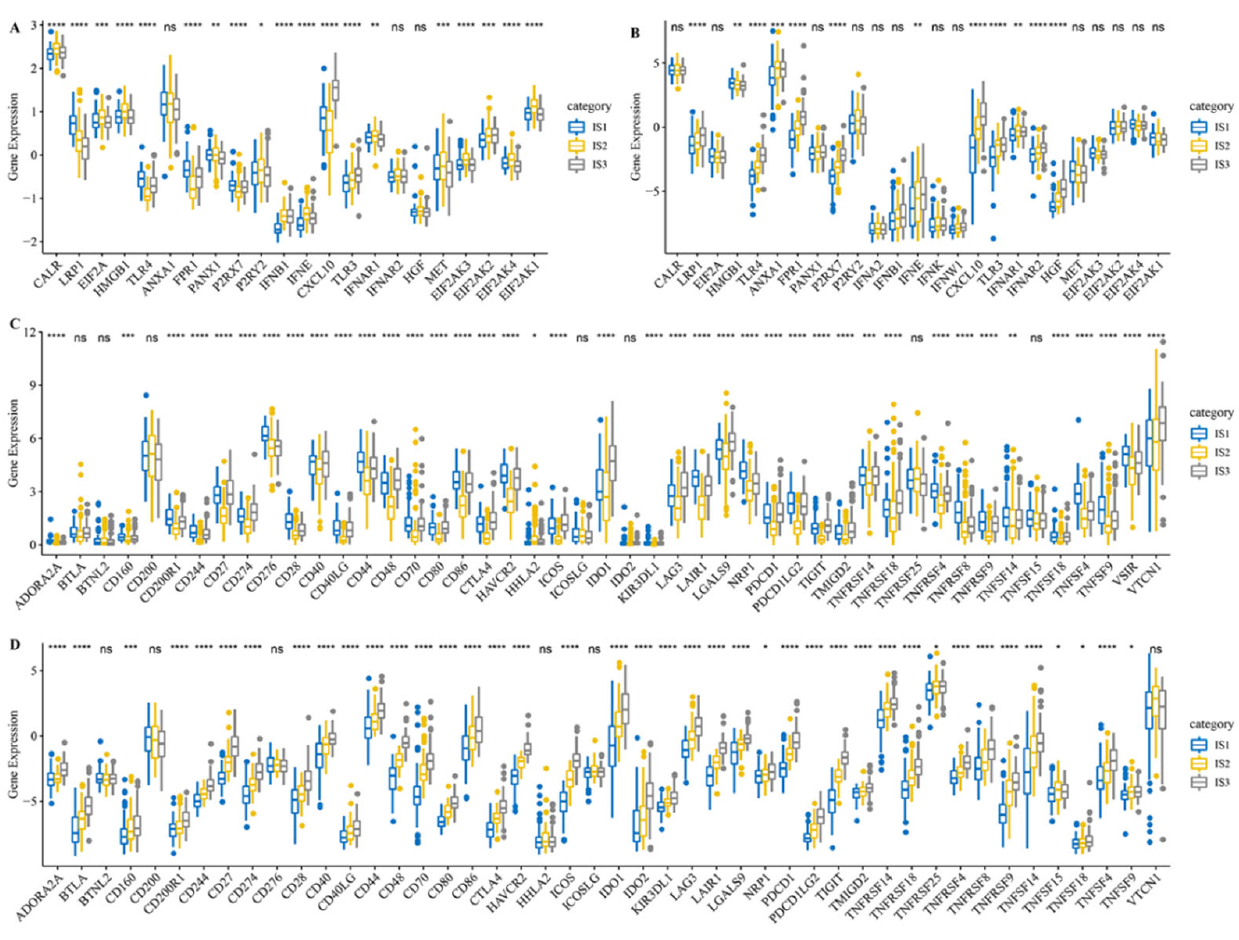
Figure 3. Different expression of ICDMs and ICPs among three immune subtypes. ( A , B ) Differential expression of ICDMs among the OC immune subtypes in the TCGA cohort ( A ) and GSE32062 cohort ( B ). ( C , D ) Differential expression of ICPs among the OC immune subtypes in the TCGA cohort ( C ) and GSE32062 cohort ( D ). * p < 0.05; ** p < 0.01; *** p < 0.001; **** p < 0.0001; and ns, no significance.